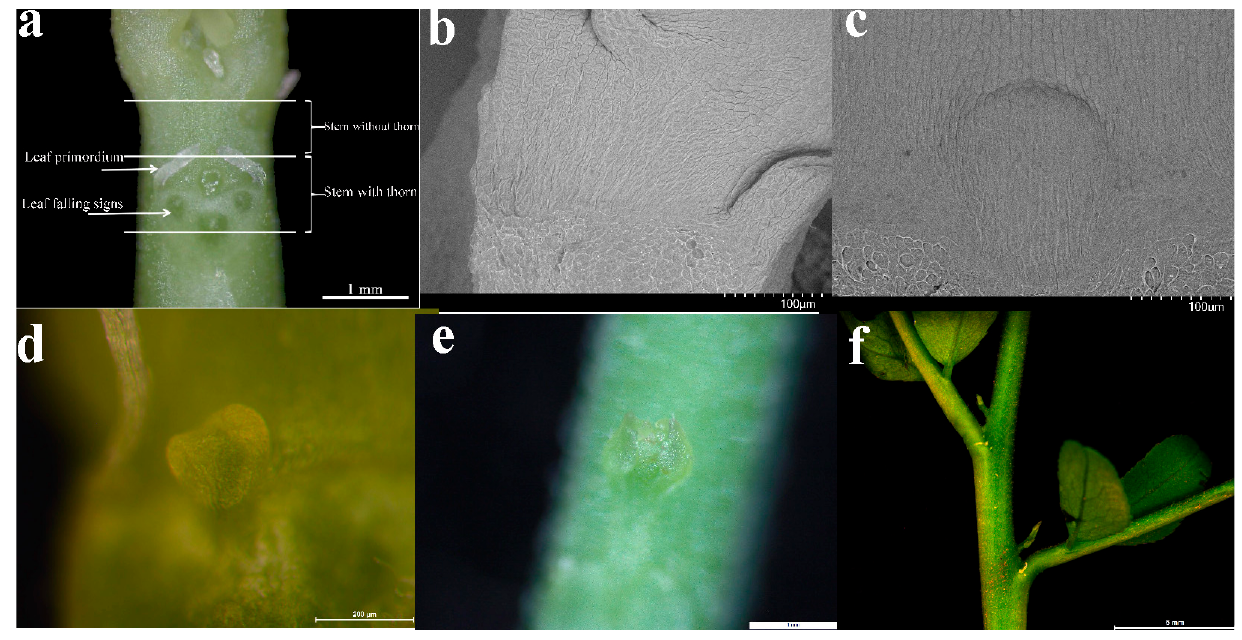
Figure 6. Demonstration diagram of test material collection. ( a ): Sampling stem section collection normal; ( b ): the thorn-free stage (2 DAG); ( c ): thorn primordium stage (3 DAG); ( d ): the stage of basic completion of scale leaves (7 DAG); ( e ): the thorn differentiation stage (8 DAG); ( f ): the thorn basic structure formation period (14 DAG).